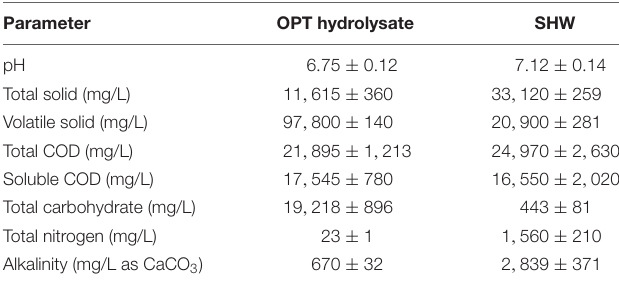
TABLE 1 | Characteristics of oil palm trunk hydrolysate (OPT) hydrolysate and slaughterhouse wastewater